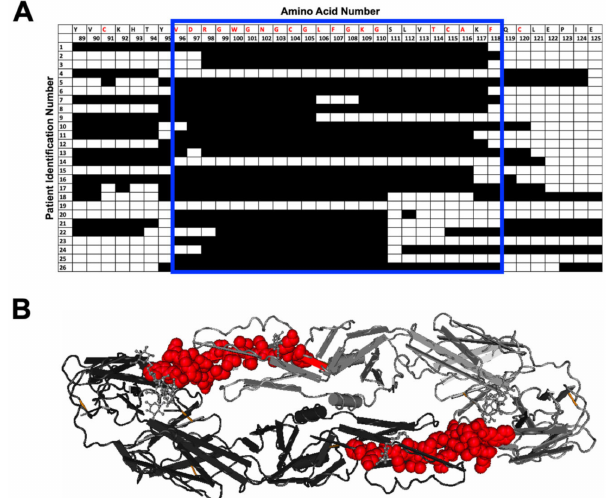
Figure 3. Individual amino acid selection for the fusion loop region. ( A ) Patterns of patient selection of amino acids of the wing domain of the E protein were analyzed for each individual amino acid position. Patients selecting for a specific amino acid were filled in (black), and if no selection was seen for the amino acid position, the box remained unfilled. Amino acids conserved among all 4 serotypes are written in red along the top of the table. The fusion loop has been highlighted by a blue box. ( B ) DENV envelope protein dimer is shown with red highlighting the fusion loop amino acids selected in our DSCB